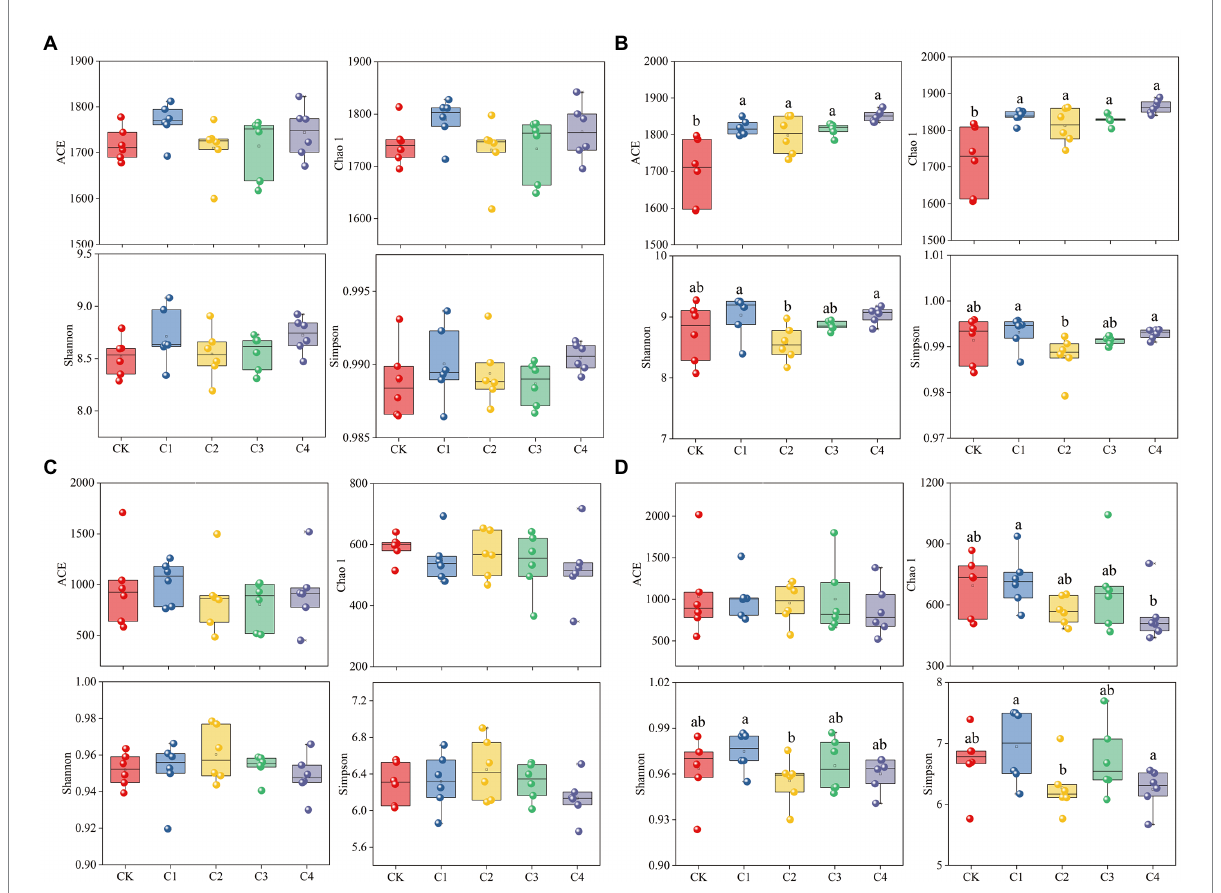
FIGURE 3 Effect of biochar addition on the α -diversity of soil microbial communities. (A) α -diversity of the bacterial communities in bulk soil. (B) α -diversity of the bacterial communities in rhizosphere soil. (C) α -diversity of the fungal communities in bulk soil. (D) α -diversity of the fungal communities in rhizosphere soil. Different lowercase letters indicate significant differences among biochar application treatments ( p <